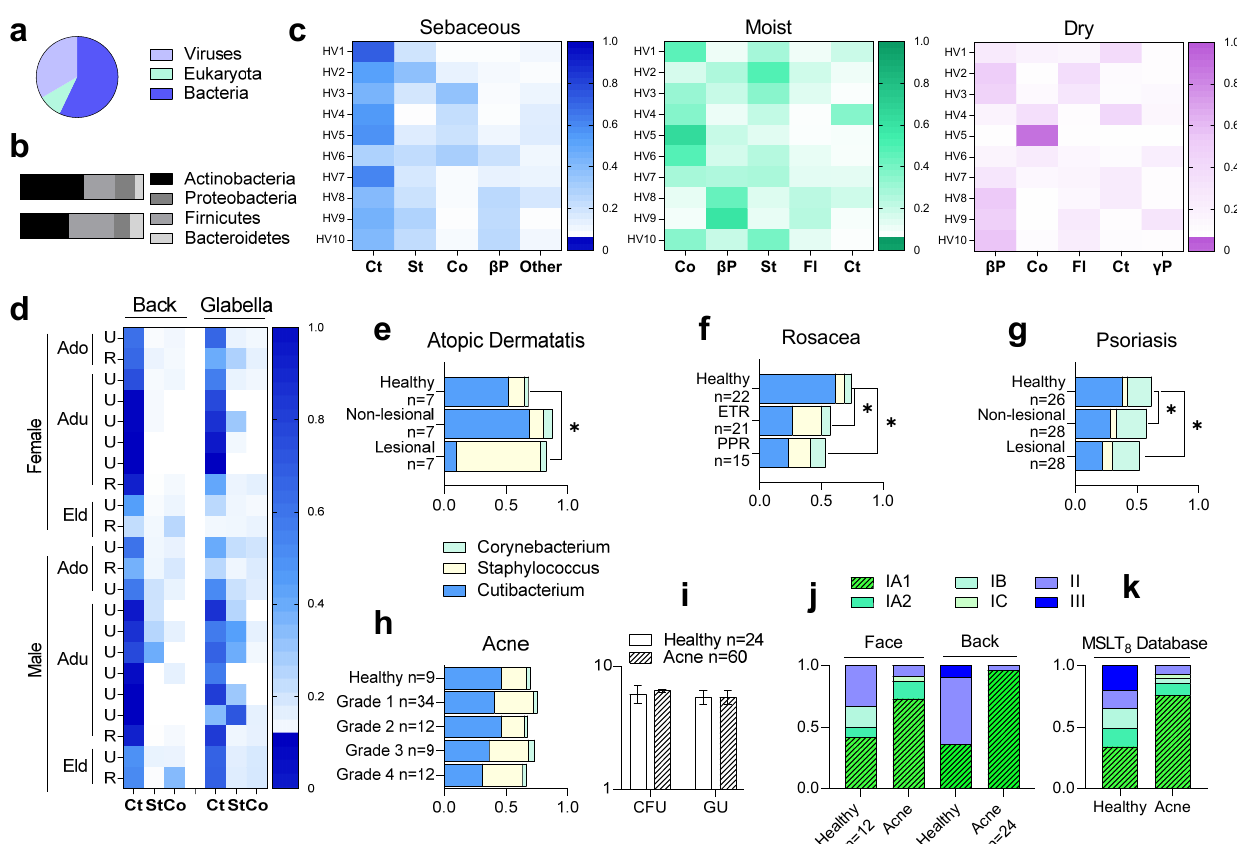
Figure 1. Cutibacterium acnes in the human skin microbiome. ( a ) Relative abundance of skin microbiota across kingdoms in 15 heathy volunteers (HV) (9 males, 6 females) sampled in 18 different skin sites, adapted from Oh et al., 2014 [7]. Bacterial genomes predominate at most sites. ( b ) The analysis of 16S ribosomal RNA of 10 HV (20 sites sampled, upper bar graph) and 9 HV (27 sites sampled, lower bar graph) shows that most of the sequences are attributed to four phyla, adapted from Grice et al., 2009 [13] and Costello et al., 2009 [14], respectively. Over this, skin microenvironments also vary drastically in their level of bacterial diversity. ( c ) In 10 HV sampled in sebaceous, moist, and dry sites, the relative abundance of Cutibacterium (Ct, formerly Propionibacterium), Staphylococcus (St), Corynebacterium (Co), Betaproteobacteria ( β P), Flavobacteria (Fl), and Gammaproteobacteria ( γ P) is strongly shaped by the niche, adapted from Grice et al., 2009 [13]. ( d ) The predominating relative abundance of Cutibacterium in sebaceous sites is relatively stable over the 22 HV from different genders, ages (Ado: teenager, Adu: adult, Eld: elderly), and locations (U: urban, R: rural), adapted from Findley et al., 2013 [17] and Ying et al., 2015 [18]. However, this relative abundance of Cutibacterium genus is significantly decreased (*: p- value < 0.05) in ( e ) atopic dermatitis lesional regions (2 sebaceous (interscapular and retroauricular) and 1 moist (antecubital fossa) sites sampled in 18 to 60yo males ( n : number of volunteers)), adapted from Francuzik et al., 2018 [29], ( f ) rosacea lesional regions (ETR: erythematotelangiectatic rosacea, PPR: papulopustular rosacea, 1 sebaceous site (cheek) sampled in 18 to 64yo males and females), adapted from Wang et al., 2020 [39], and ( g ) psoriasis non-lesional and lesional regions sampled in 1 sebaceous (scalp), 2 moist (axilla and gluteal), and 3 dry (trunk, arm, leg) skin sites, adapted from Chang et al., 2018 [47]. ( h ) Interestingly, no significant alteration of the relative abundance of Cutibacterium genus was observed over 67 patients (22-23 year old) with no and/or different acne severity sampled on the cheek, adapted from Li et al., 2019 [61]. ( i ) No difference in the bacterial load (log colony forming units (CFU) and log genomic units (GU) per strip) between 15-30yo male and female healthy or acne patients sampled on the face, adapted from Pecastaings et al., 2018 [62]. The sharp difference between healthy and acne patients is in the decrease in the diversity of C. acnes phylotypes. ( j ) Comparison of the relative abundance of the 6 phylotypes of C. acnes between 16-35yo male and female healthy and acne patients, adapted from Dagnelie et al., 2017 [65]. ( k ) Relative abundance and statistically significant enrichment of type IA1 with acne is confirmed by the analysis of the current MSLT 8 isolate database, adapted from McLaughlin et al., 2019 [64].